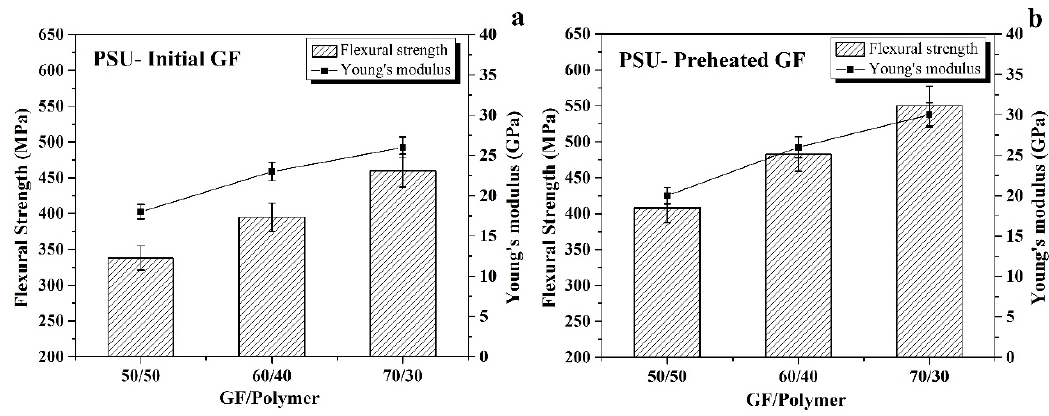
Figure 3. Flexural strength and Young’s modulus for the initial GF ( a ) and ( b ) the preheated GF reinforced composites.